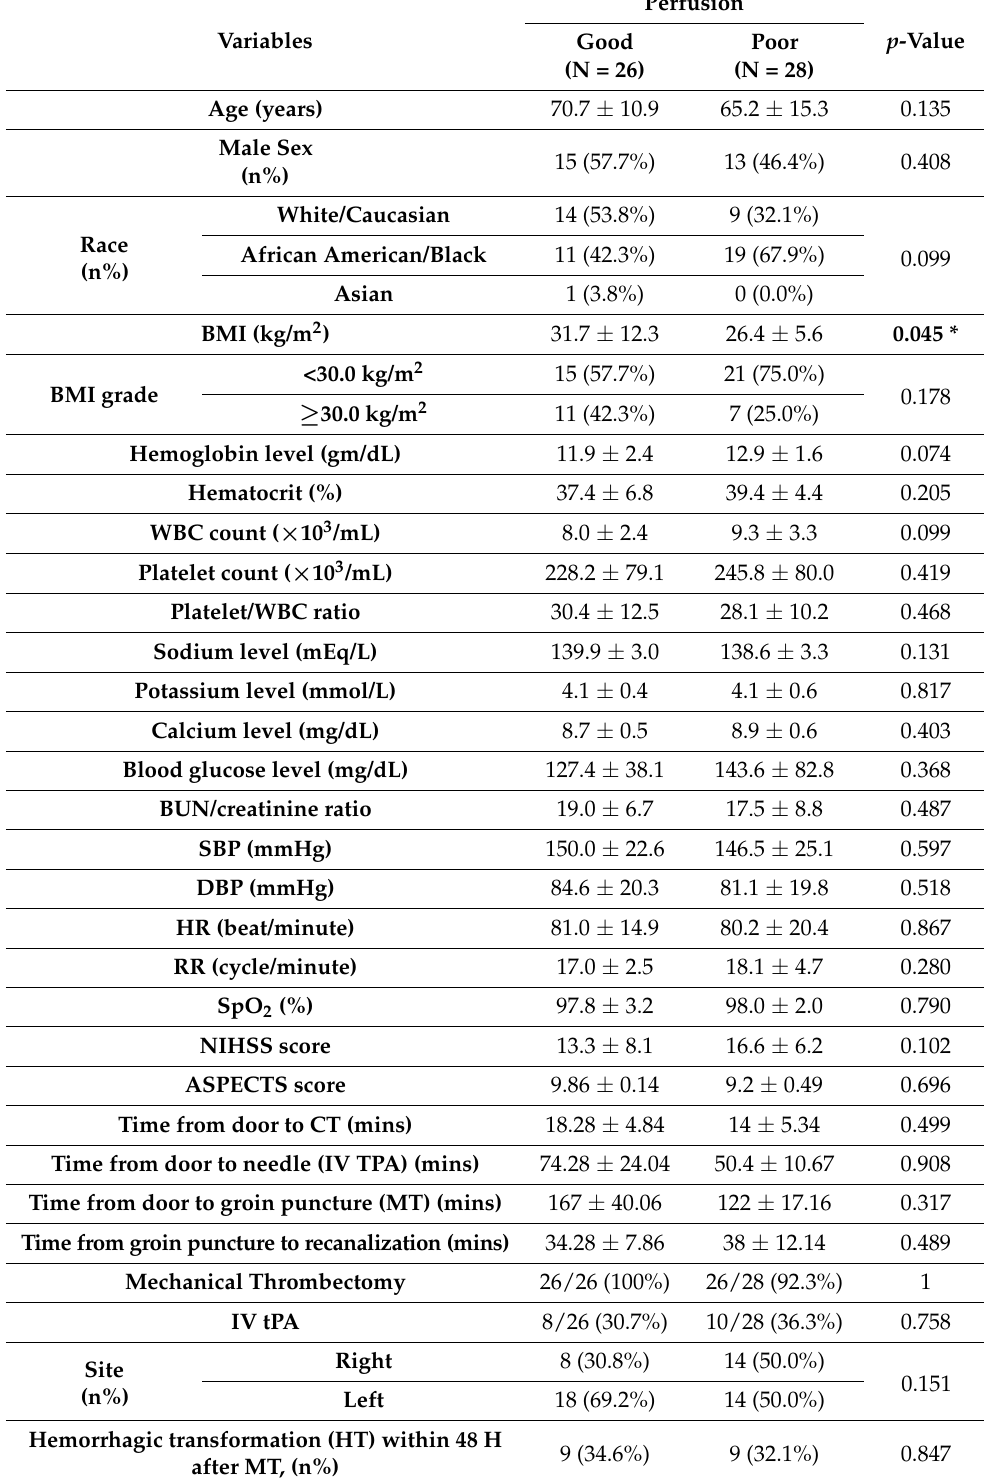
Table 2. Comparison in the baseline characteristics according to the collateral status (HI).